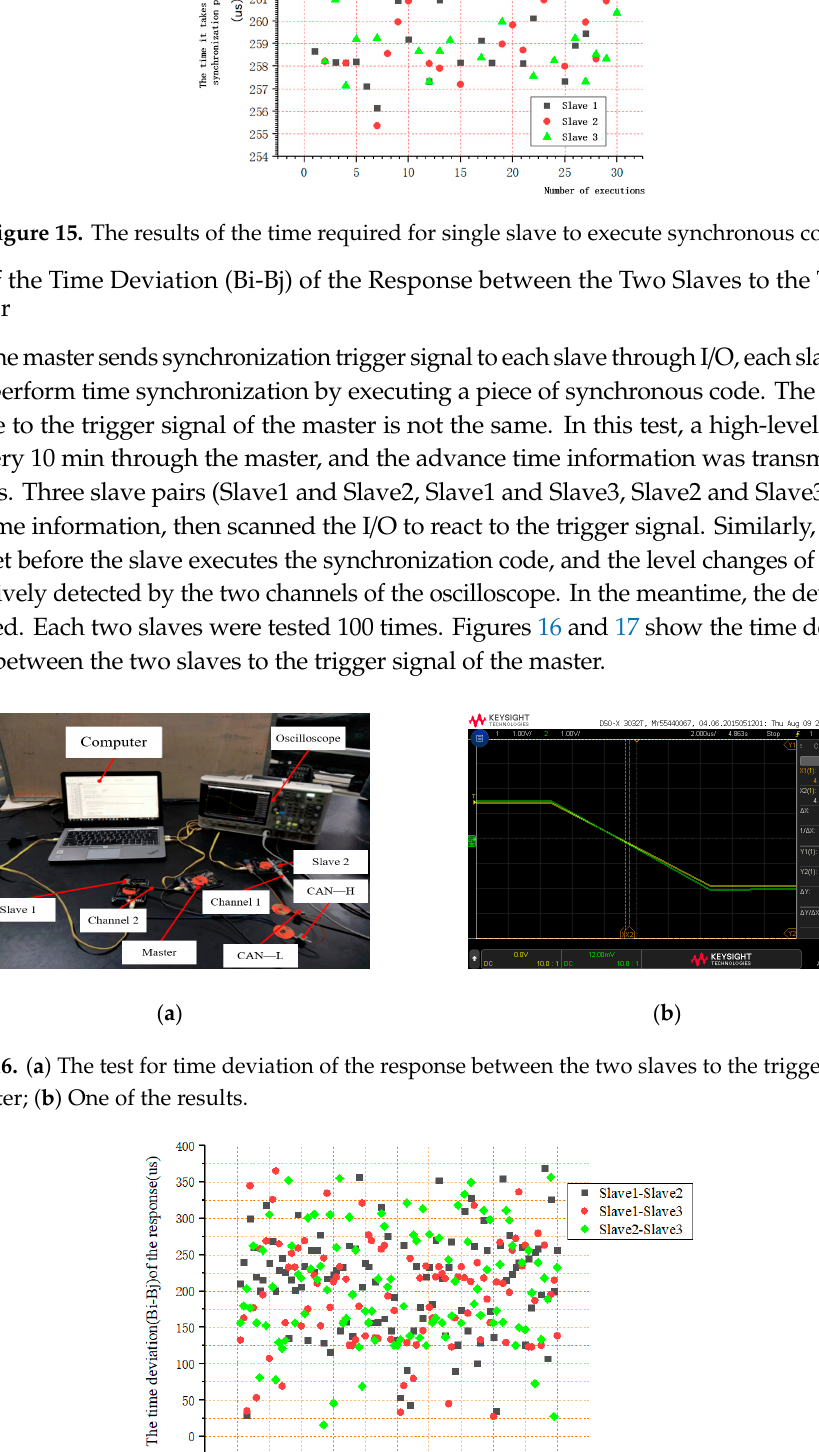
( b ) Figure 14. ( a ) The test for the time of synchronous code; ( b ) One of the results. The results are illustrated in Figure 15. The longest time was 266.376 us, and the shortest time